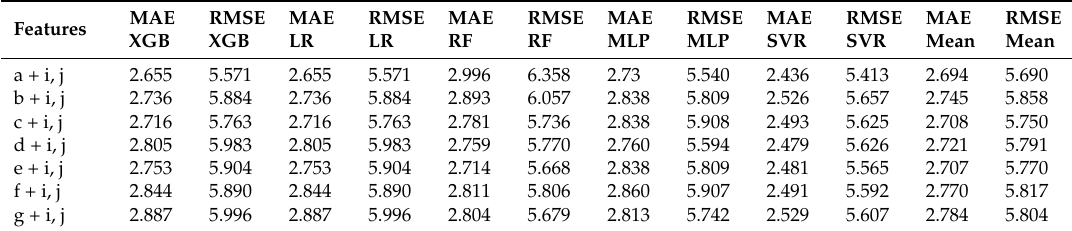
Table 2. RMSE and MAE using the same-pixel features from Table 1, plus an additional pixel location feature, using five different machine-learning techniques.